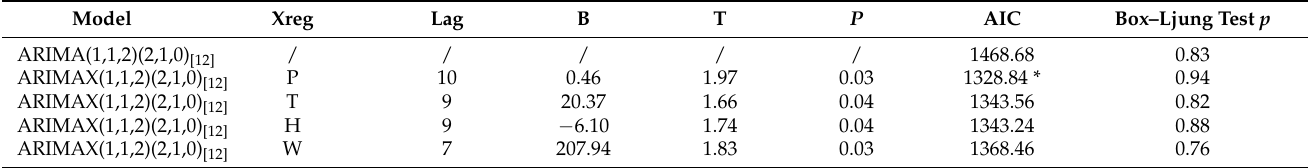
Table 4. ARIMAX models that passed parameter tests and model diagnosis.